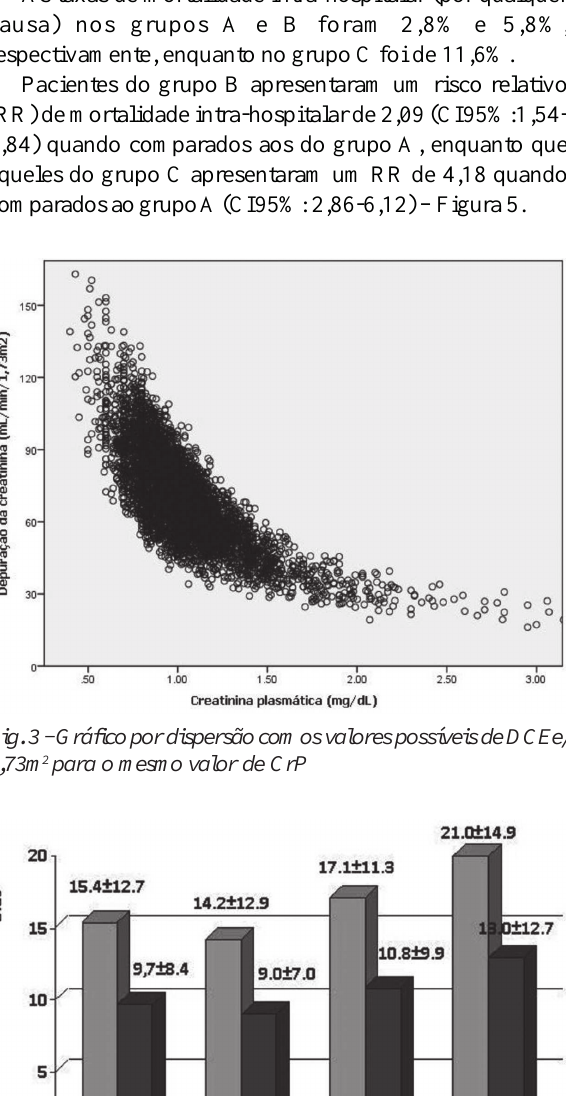
Fig. 1 e 2 - Coordenadas de sensibilidade e de especificidade da curva ROC relativas a valores de CrP para DCEe/1,73m 2 < 60 mL/min para ambos os gêneros